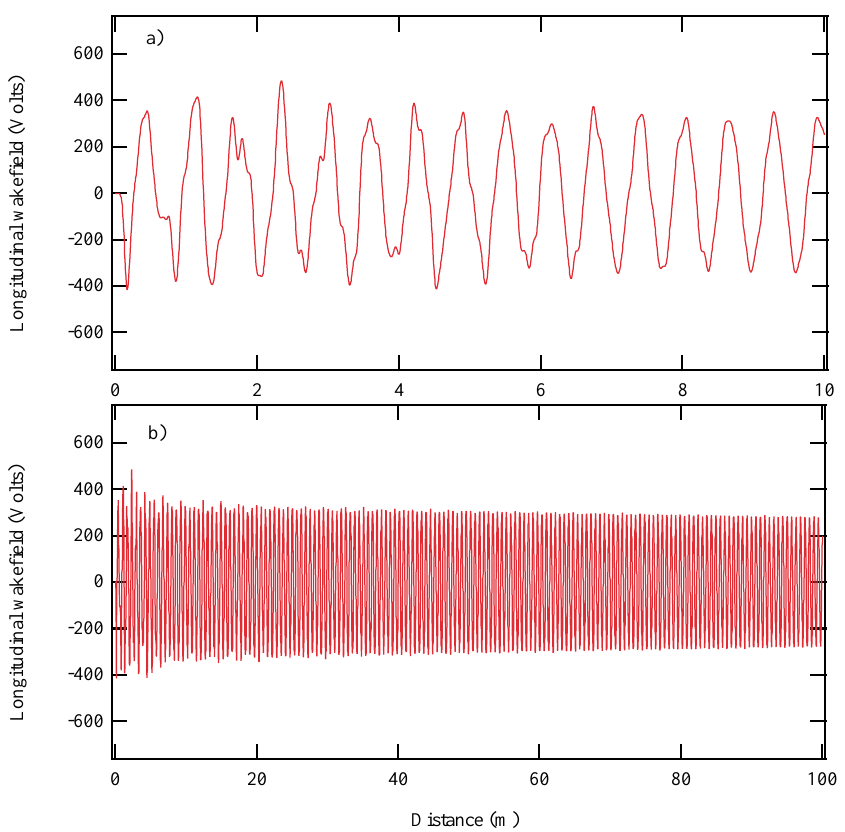
FIG. 3. (Color) Longitudinal wakefield calculated using MAFIA T3 with a 3 cm bunch length. (a) Short-range wake and (b) long- range